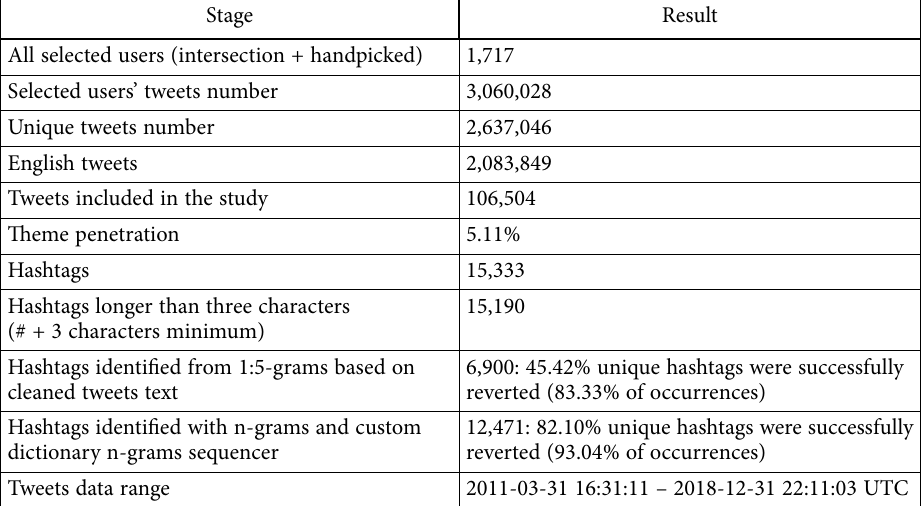
Table 3. Results of the search for relevant tweets (source: own study based on Twitter, retrieved on 18th of February 2019)